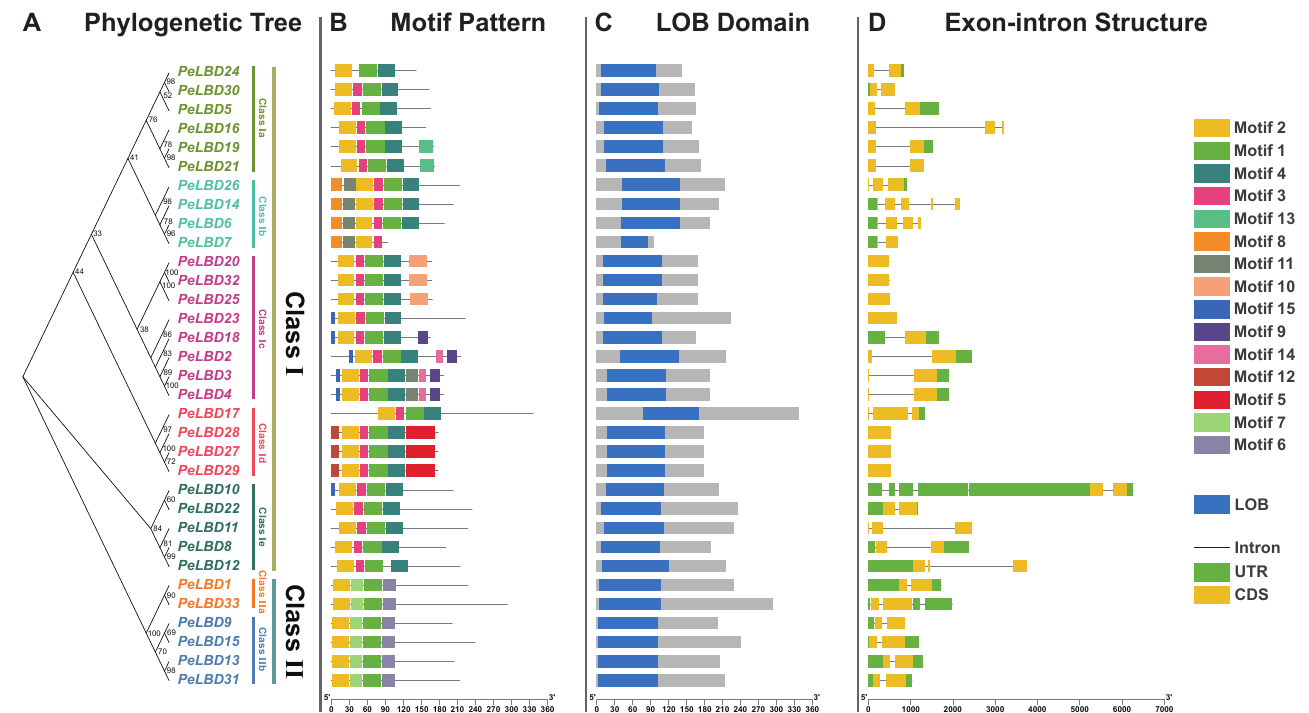
Figure 3. The phylogenetic relationship, conserved motifs and gene structure of PeLBD proteins. ( A ) The maximum likelihood (ML) phylogenetic tree of PeLBD proteins was constructed using full-length sequence with 1000 bootstrap replicates; ( B ) Distribution of conserved motifs in PeLBD proteins. A total of 15 motifs were predicted, and the scale bar represents 30 aa; ( C ) Distribution of LOB domain of PeLBD genes; ( D ) The gene structures of the PeLBD genes, include introns (black lines), exons (CDSs, yellow rectangles) and untranslated regions (UTRs, green rectangles). The scale bar indicates 1